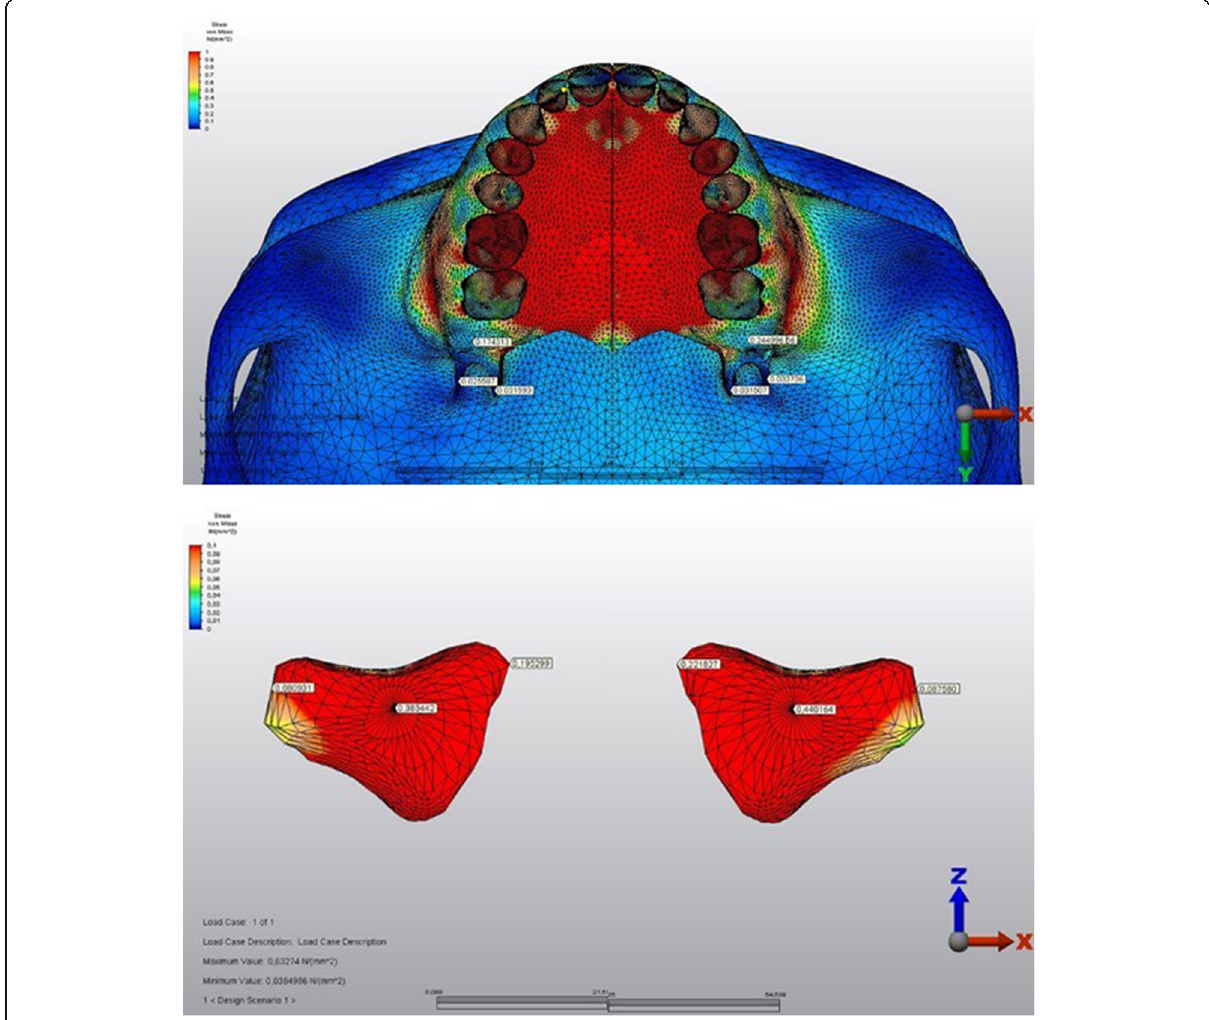
Fig. 8 The stressed areas on the tuber, zygomatic buttress, and pterygoid processes from the occlusal plane (above). The stress levels were declined in the medio-lateral direction both on the right and left maxillary sinus walls (below). The index is descending 0.1 points from 1.0 to 0.0 as 1.0-0.9-0.8-0.7-0.6-0.5-0.4-0.3-0.2-0.1. (Red to